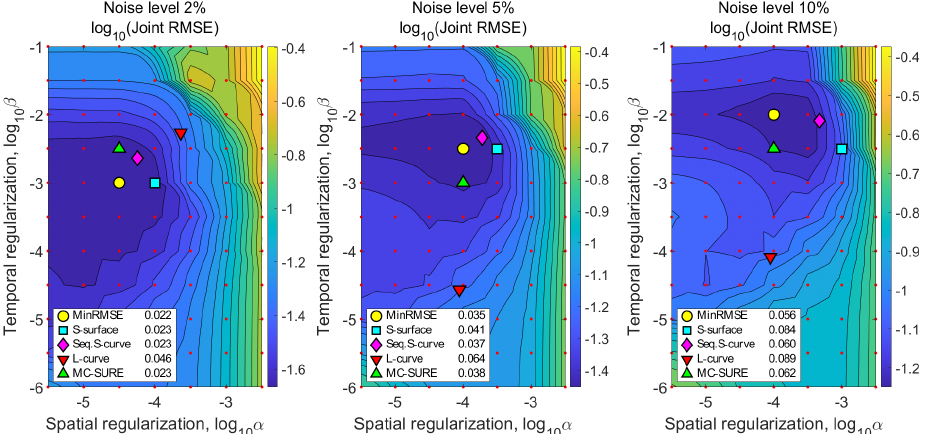
Figure 4. Joint RMSE contours with noise levels 2%, 5% and 10% with the parameters of the four different reconstructions marked and the jRMSE values of the chosen reconstructions. The images show that the regularization parameter pairs obtained with the sparsity based S-surface and Sequential S-curve methods are close to the MinRMSE parameter